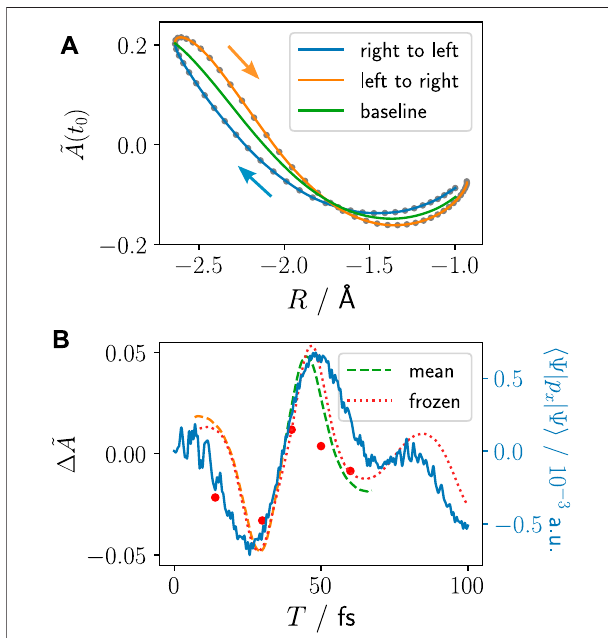
FIGURE 7 | Imprint of nuclear – electron correlation in the asymmetry of thePESforanon-equilibriumstartingpositionof R 0, r probedbyaXUVpulseat different time-delays T : (A) Asymmetry calculated according to Eq. 22 at time ofionisationindependenceofthenuclearposition R attimeofionisation, t 0 . Right to left and left to right refer to the time-delay intervals of T = [7,37]fs and T = [37,74]fs, respectively. The baseline is calculated using approach 1 ) explained in the text as mean between left to right and right to left. (B) The nuclear – electron correlation-based asymmetry, Δ ~ A , as a function of the time delay T obtained withthe mean baseline( 1 , dashed) and the calculated frozen nucleus baseline ( 2 , dotted). As explained in the text, the mean basline can only be obtained if forth and back propagation in the same potential is available ( T = [7,37]fs and T = [37,74]fs), whereas the frozen nucleus baseline is available for all time delay points. The red dots stem from the asymmetry calculated with the more computationally demanding Eq. 16 . The electron mean momentum is also shown, for comparison (solid blue line).